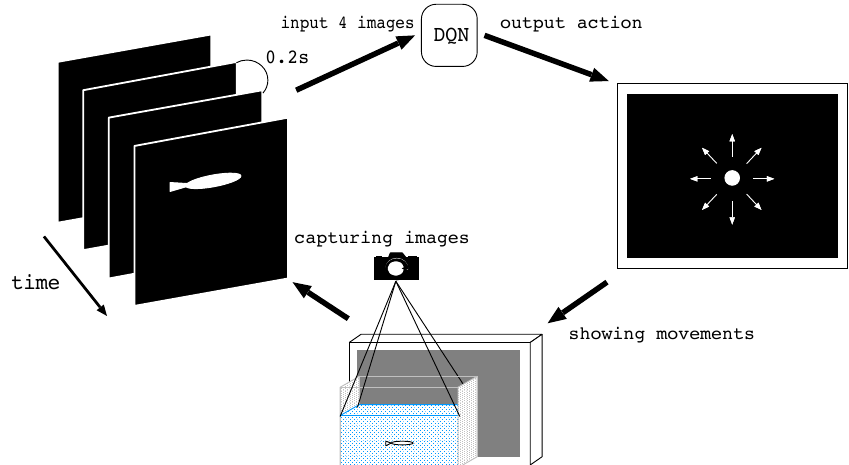
Figure 1: Cycle of our experiment.